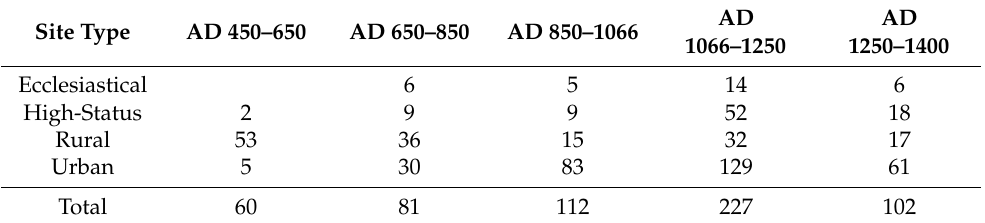
Table 1. Summary of all sites included in the dataset by phase and site type.